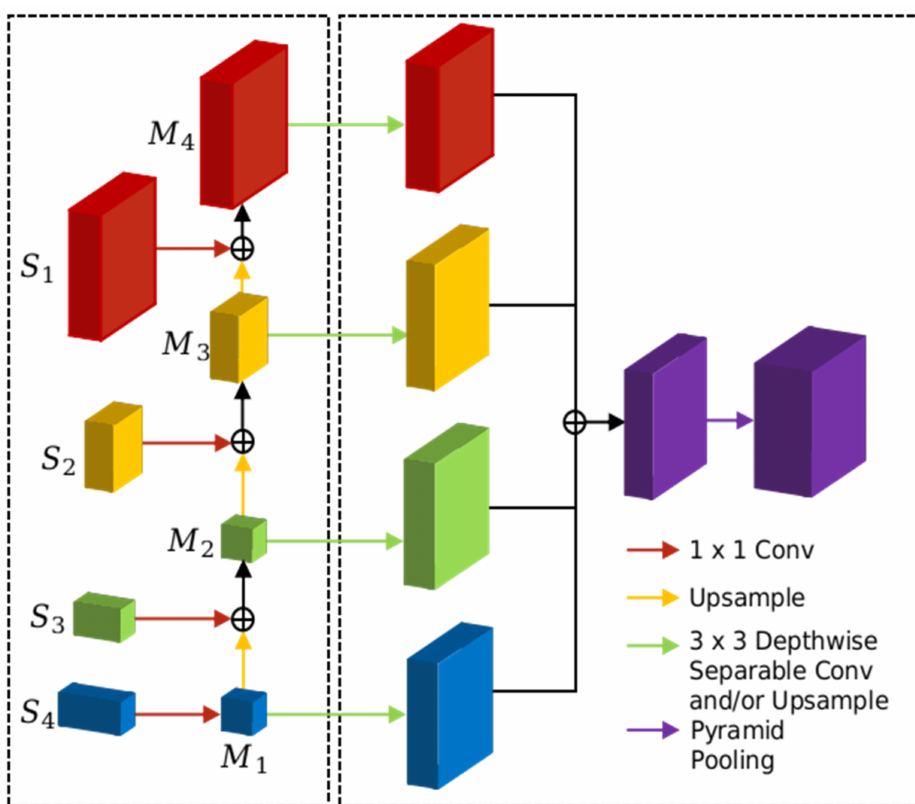
Figure 4. The structure of our